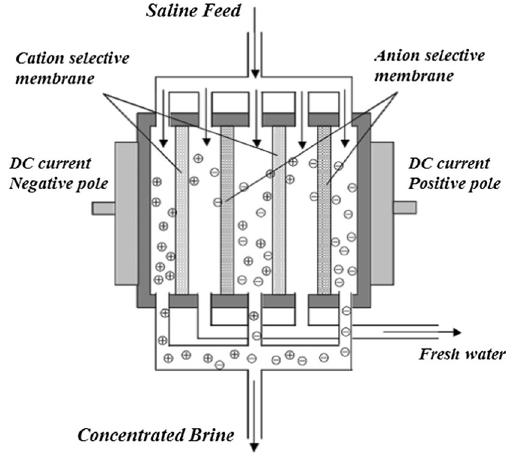
Fig. 13 Schematic of the electrodialysis process for producing fresh- water and concentrated brine (Miller 2003)